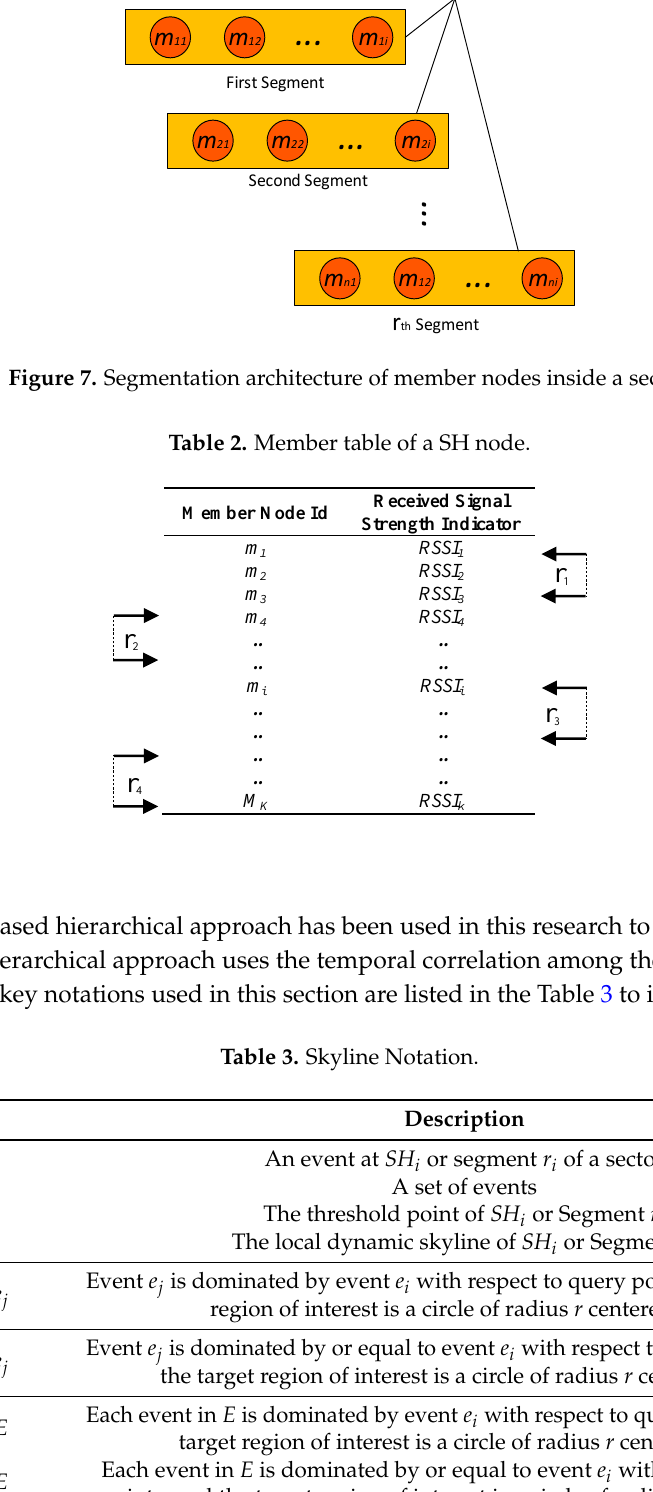
Algorithm 3. Build_Tree(), implemented at each SH.